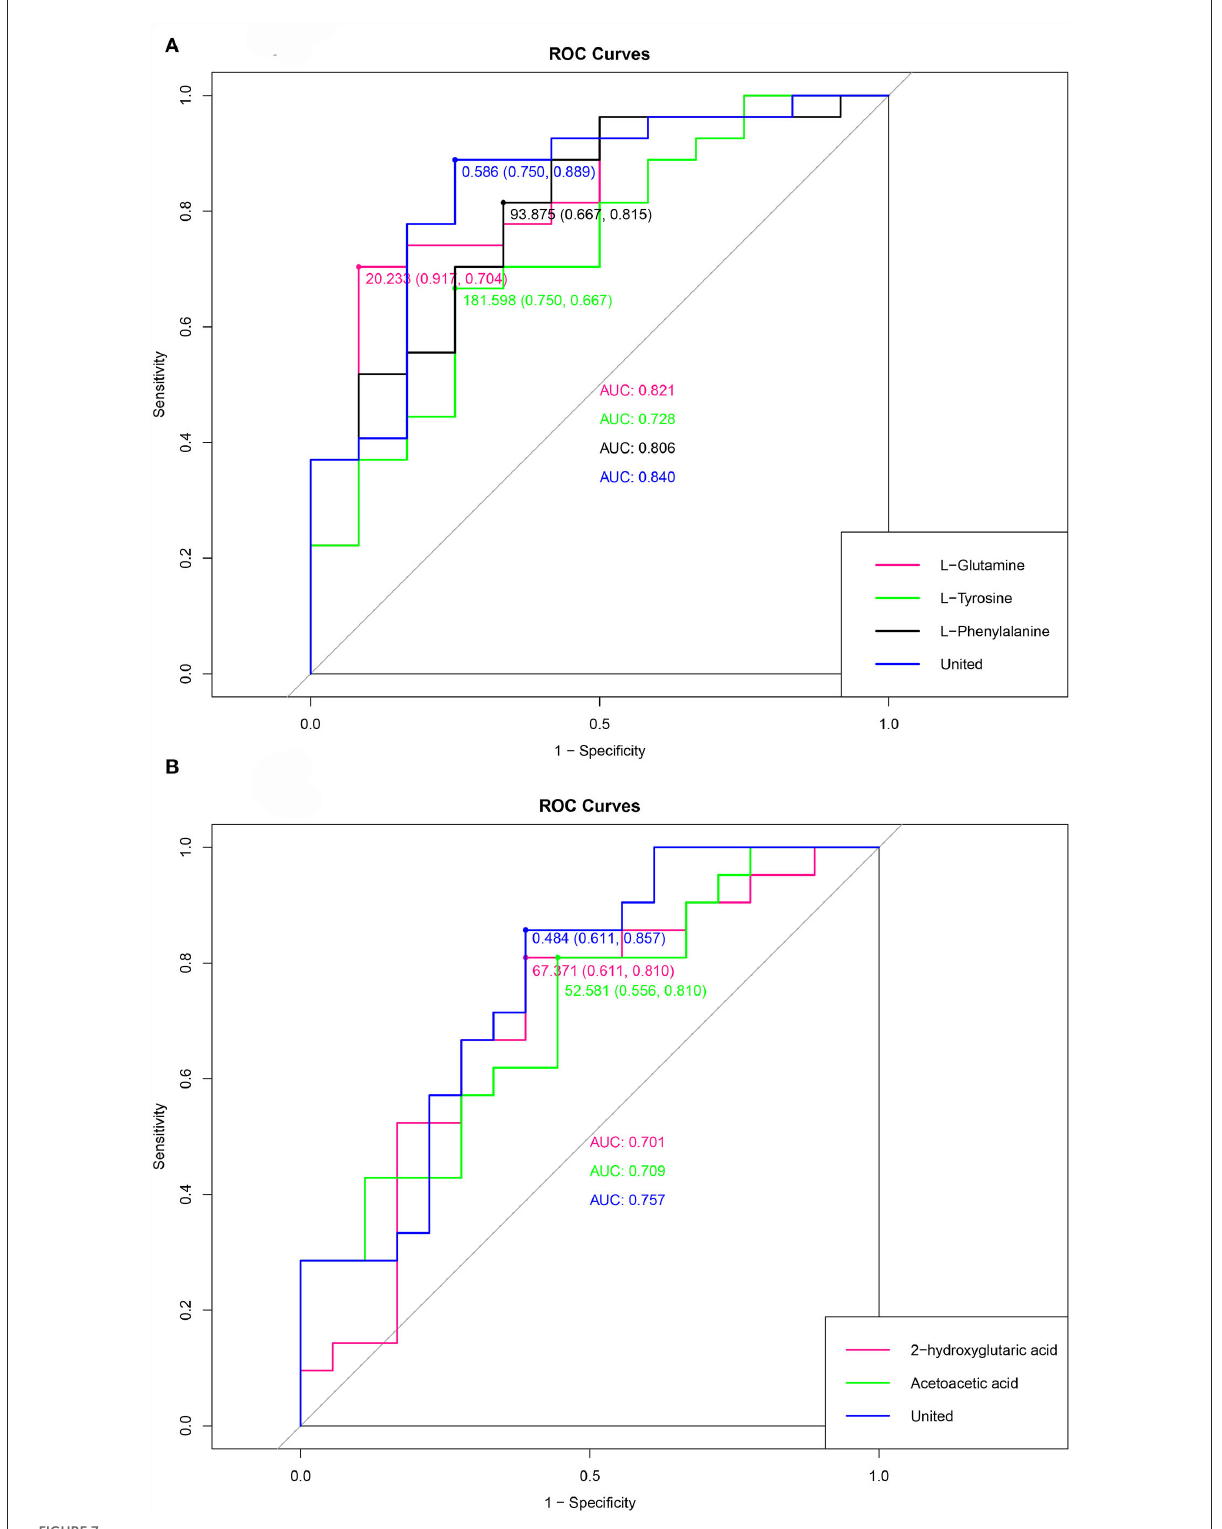
FIGURE7 (A) is the ROC curve of the environmental factor group (DUvsG), and DUvsG refers to the group “Deep-underground vs. ground”; (B) is the ROC curve of the sleep quality group (GSQvsPSQ), and GSQvsPSQ refers to the group “Good sleep quality vs. poor sleep quality”. Different colors correspond to a metabolite, and “united” refers to the curve obtained by calculating several metabolites that were mentioned